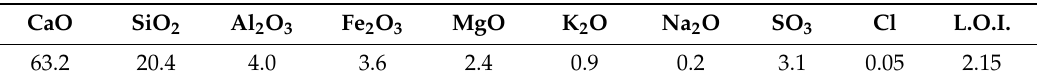
Table 1. Chemical composition of